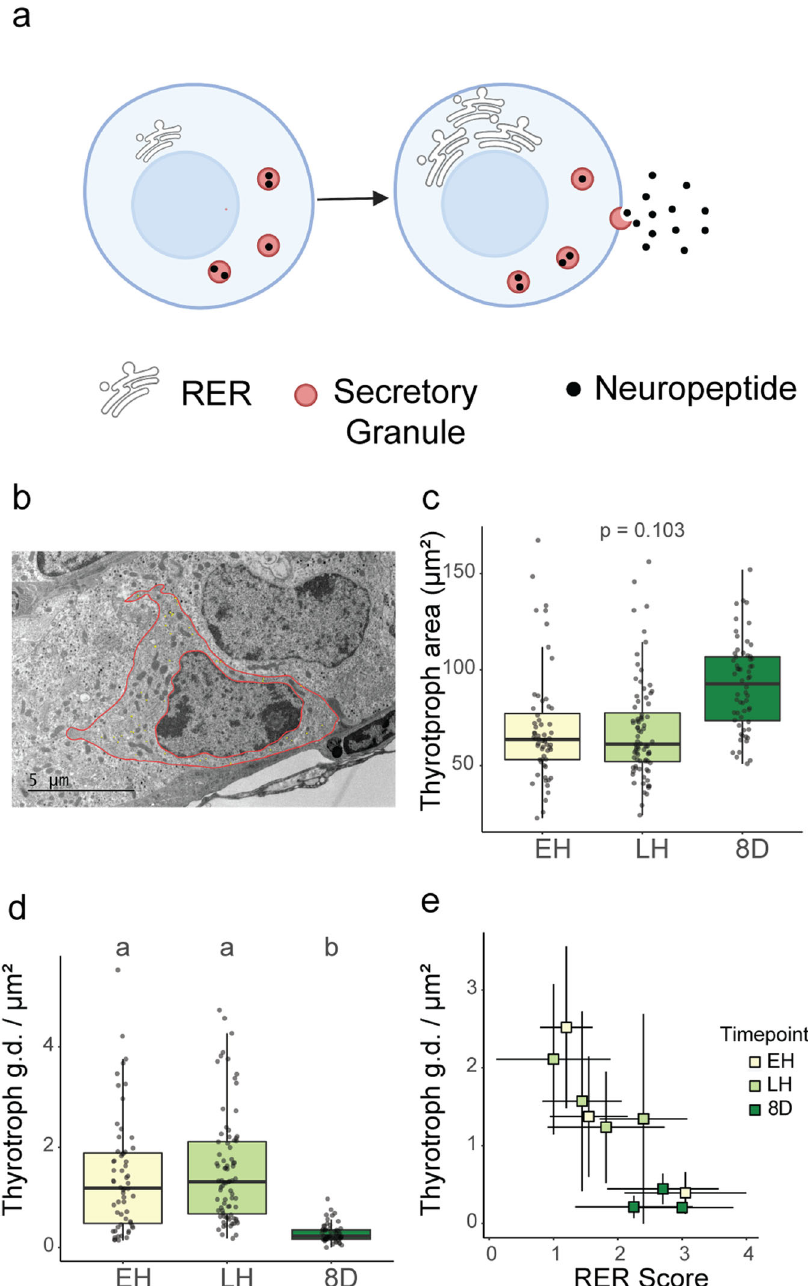
Fig. 2 Cellular remodeling of thyrotrophs post-hibernation. a Schematic of morphological changes associated with neuropeptide secretion. b Electron microscopy (EM) image of thyrotroph cell with outline of the total cytoplasmic and nuclear area shown in false pink coloring. c Cross sectional area ( μ m 2 ) and d secretory granule density of thyrotroph cells in the pars tuberalis of female arctic ground squirrels. e The relationship between individual PT thyrotroph secretory granule density and individual thyrotroph RER (rough endoplasmic reticulum) activity. In panel e , data points and error bars represent means ± SD. In all boxplots, colored shading represents sampling groups, the center line in the box plot represents the median, box boundaries represent the 25th and 75th percentiles, error bars represent the 25th and 75th percentiles ± 1.5 times the interquartile range, and lower-case letters indicate signi fi cantly different comparisons using linear-mixed effects modeling ( p < 0.05). For sample sizes, see methods. See also Supplementary Fig.